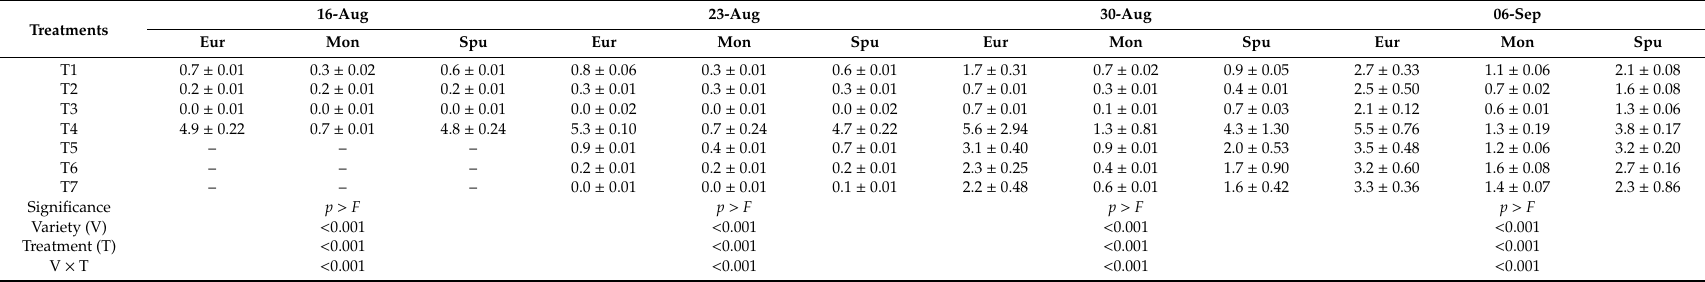
Table 4. Average ( ± standard error) number of sprouts (no.) per tuber with a minimum length of 2 mm of three varieties (Europa, Monalisa, Spunta) subjected to seven dormancy-breaking treatments applied during pre-planting storage condition (Experiment 1).